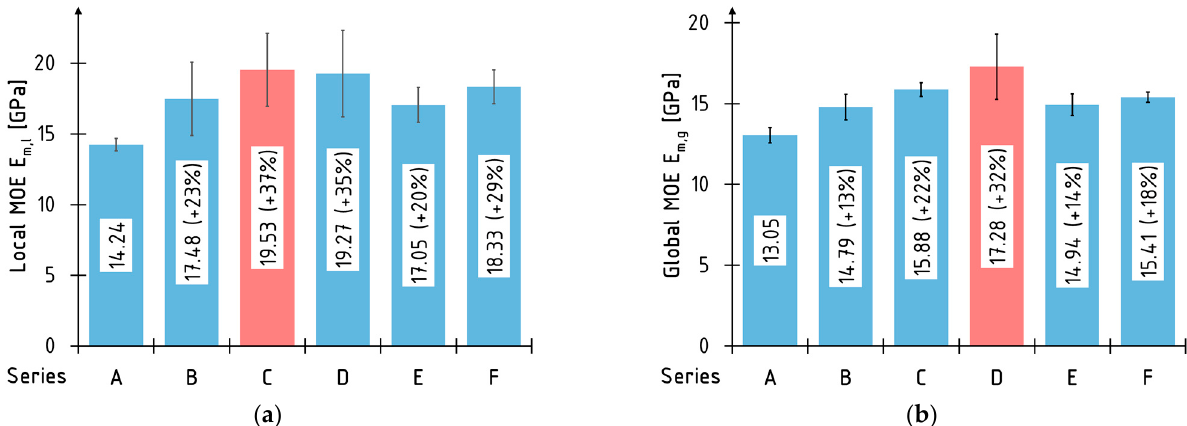
Figure 20. Average values of modulus of elasticity: ( a ) local E m,l ; ( b ) global E m,g .